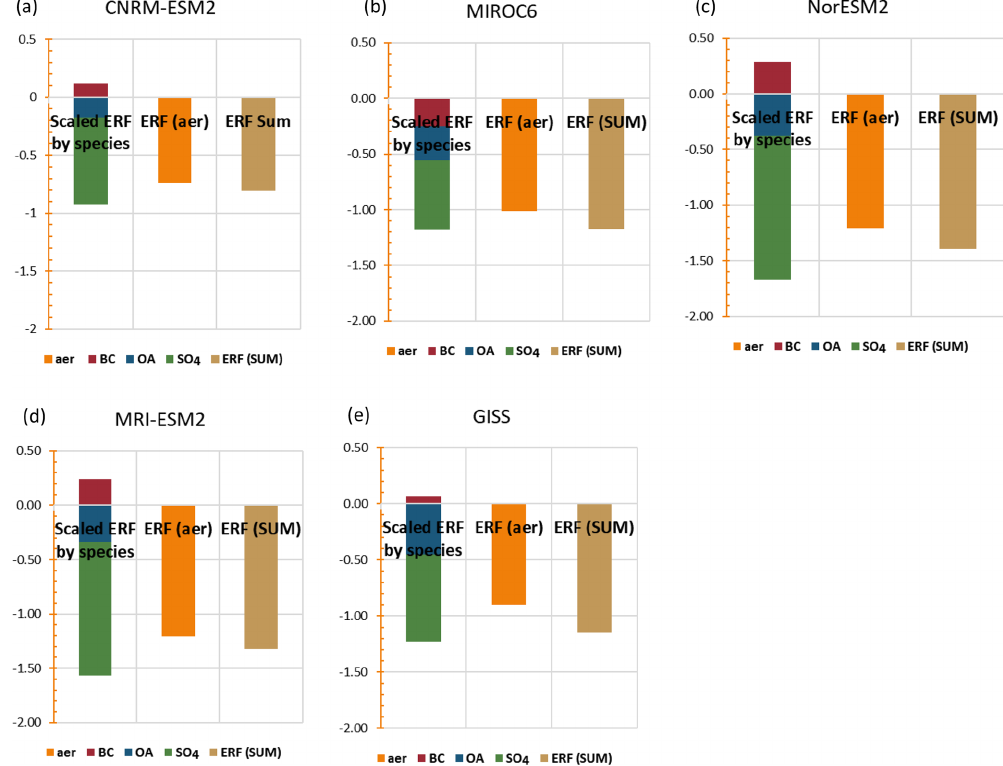
Figure 4. The contributions to the ERF for piClim-aer from the individual species, the sum of the scaled ERFs and the ERF calculated directly from the piClim-aer experiment for five of the